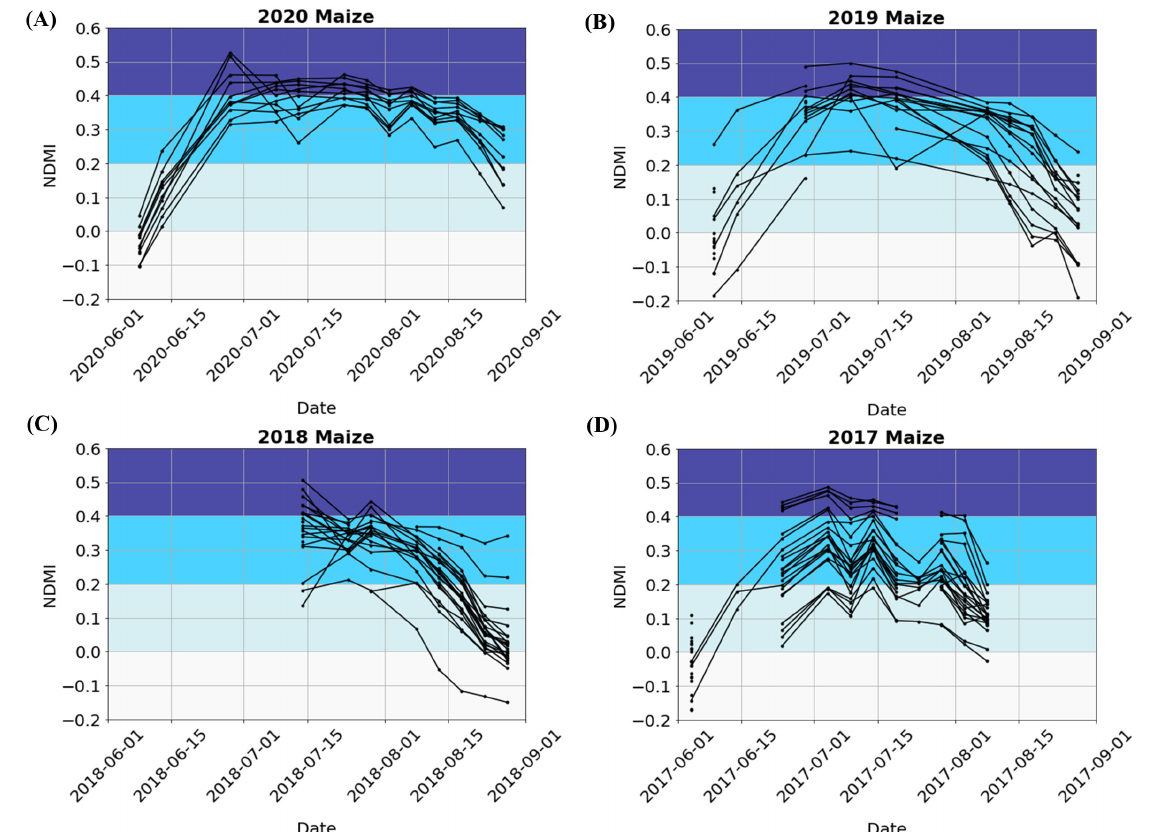
Figure 3. Time series of NDMI values at maize parcels in four growing seasons: 2020 ( A ), 2019 ( B ), 2018 ( C ), and 2017 ( D